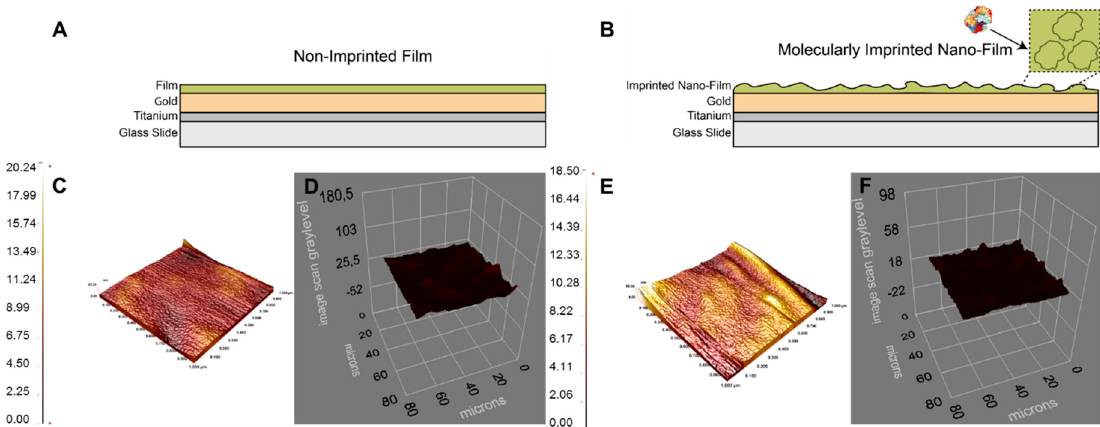
Figure 1. Schematic illustrations, atomic force microscope and ellipsometry images of the non-imprinted ( A , C , D ) and molecularly imprinted ( B , E , F ) nanofilms.